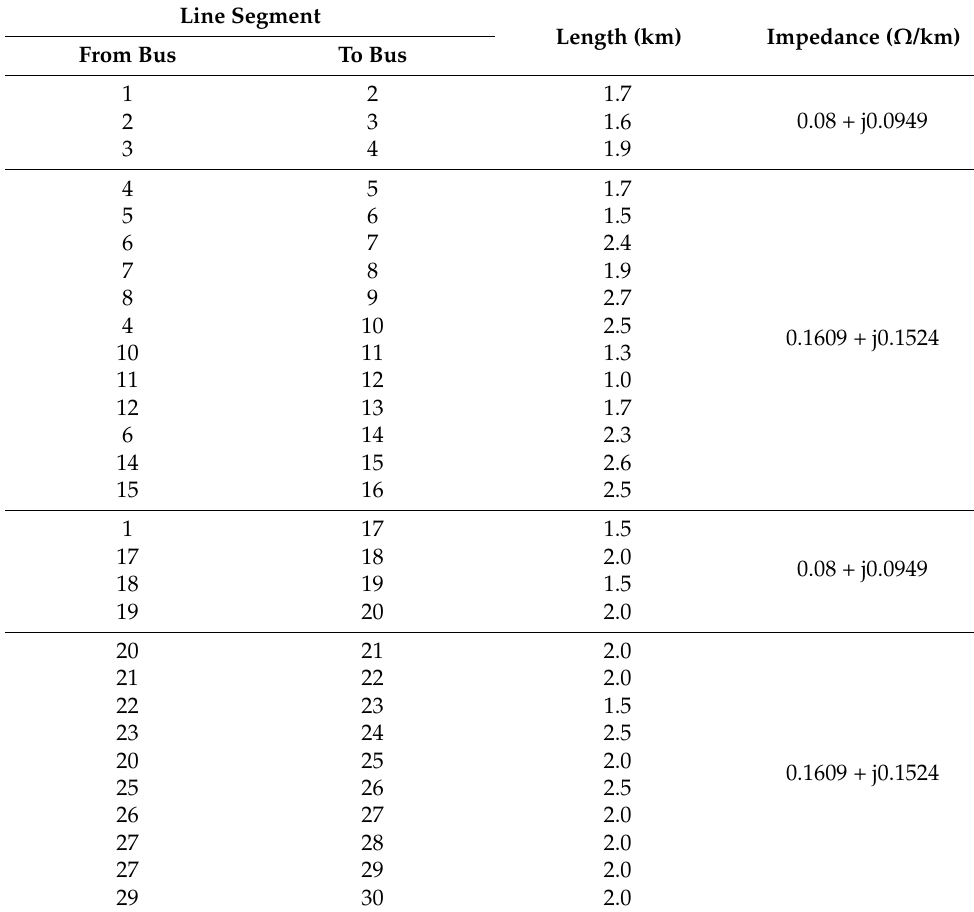
Table A1. Test network line